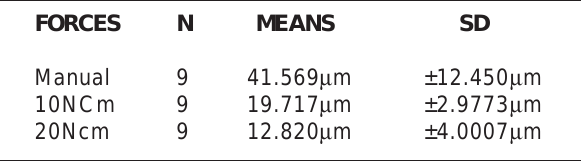
TABLE 1- Mean values and standard deviations of vertical misfit of samples, using three different forces for tightening the bridge locking screws